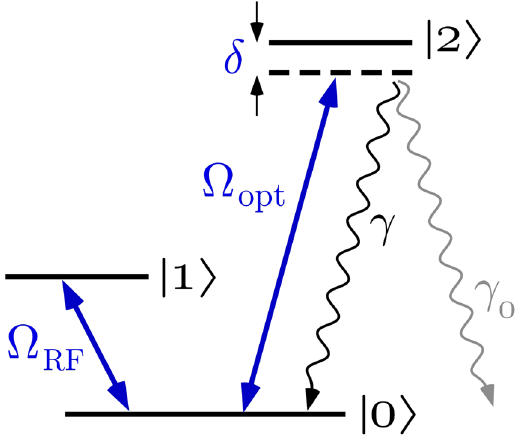
Figure 1. Level scheme used in this work. On resonance Rabi flopping on an auxiliary radio frequency (RF) transition between two ground state hyperfine levels |0 〉 and |1 〉 is induced with a Rabi frequency Ω RF . At the same time the optical transition under investigation |0 〉 → |2 〉 (or spectroscopy transition) is laser excited with a Rabi frequency Ω opt . In contrast to the radio frequency transition, the optical transition is assumed to be damped with decay constants γ and γ 0 (possible decay to other states). This decay also leads to a decoherence of the radio frequency transition that depends on the laser detuning δ in form of a Lorentzian line shape. The resulting damping of the Rabi flopping Ω RF is used as the signal to detect the |0 〉 → |2 〉